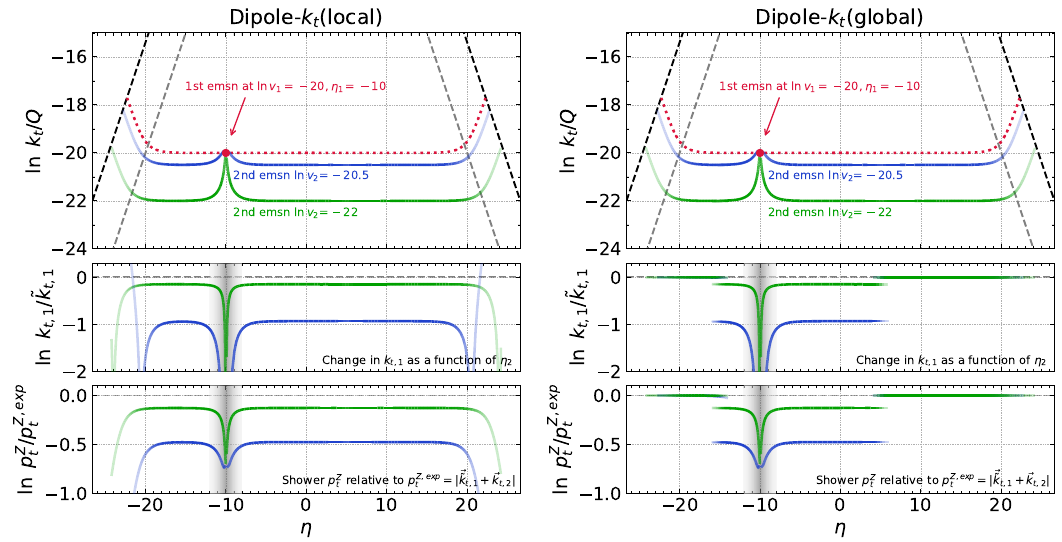
Figure 2. Double-emission contours for Dipole- k t (local) (left) and Dipole- k t (global) (right). The phase-space contours are shown as a function of ln k and η . A red dot indicates the kinematics of t /Q the first emission which has η 10 and ln v = − 20 (in the plot labels, values of v are always 1 ≈ − 1 /Q i expressed in units of Q ). For illustrative purposes, the contour of the first emission is shown with a red dotted line, whereas that of the second emission at ln v = − 20 . 5 ( ln v = − 22 ) is drawn 2 /Q 2 /Q as a blue (green) solid line. The colour shading of the lines indicates the branching probability. In the middle panels we show the logarithm of the ratio between the transverse momentum of the first emission before ( k ) and after the second emission took place ( k 0 ), which is expected to be t, 1 t, 1 zero (dashed line) except when the two emissions are close in rapidity (shaded vertical band). The bottom panels show the ratio of the observed to the expected Z transverse momentum (where again, the expectation is valid when the two emissions are well separated in rapidity, i.e. well outside the grey vertical